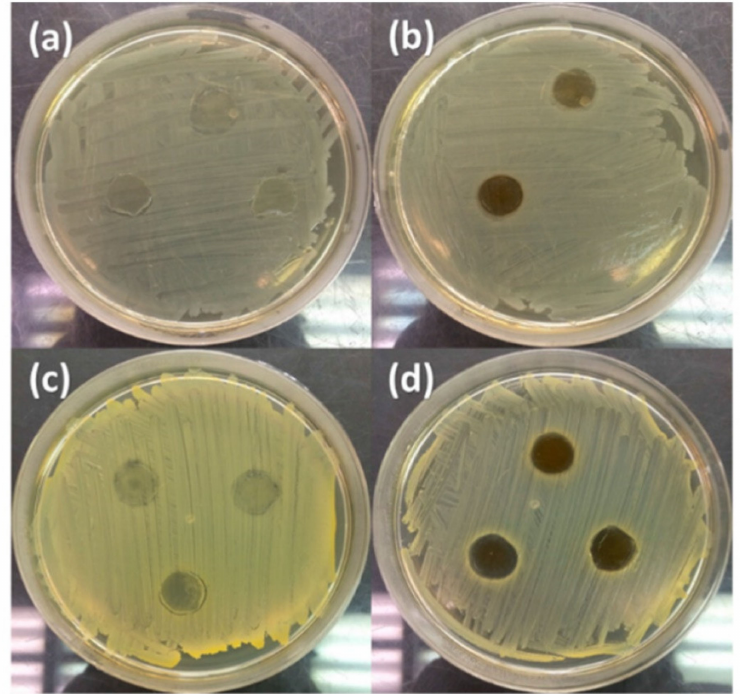
Figure 5. Photographs of the inhibition zones of PVP/CNC against E. coli ( a ) and S. aureus ( c ); and PVP/CNC-4%/AgNO 3 -0.34% against E. coli ( b ), and S. aureus ( d ). Reproduced from Ref.